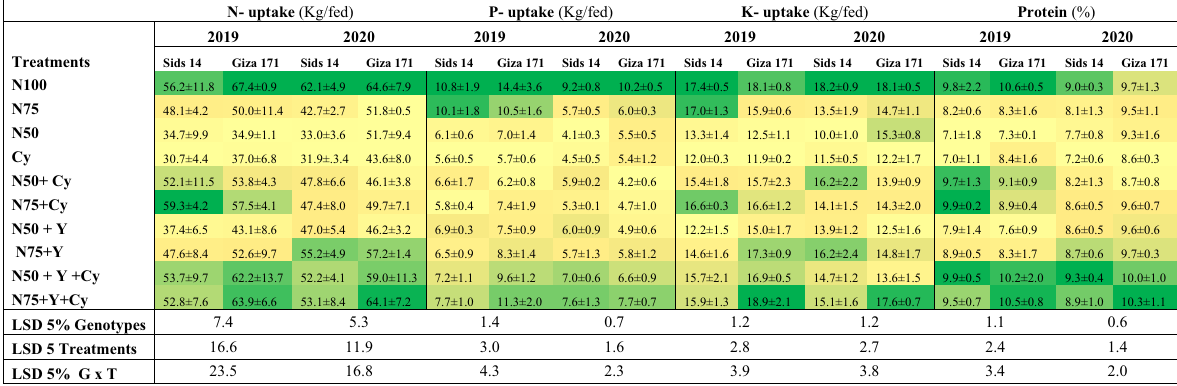
Table 3 Interactive effect of cyanobacteria (Cy), yeast (Y) inoculation and mineral fertilization (N; nitrogen dose) on macronutrient contents of wheat grains at harvest over 2019 and 2020 seasons. The color scale pattern was generated in Excel, lower values are denoted in yellow color, whereas higher values are depicted by a green color. Each value is mean of 3 independent replicates N- uptake (Kg/fed) P- uptake (Kg/fed) K- uptake